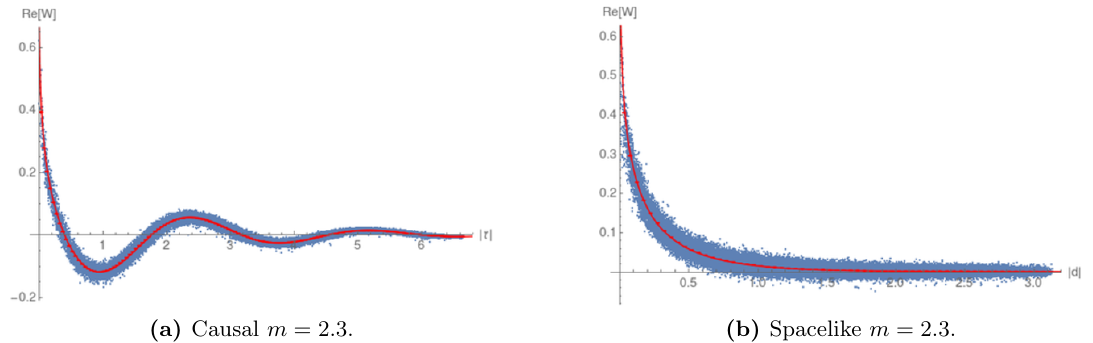
Figure 14. N = 36000 ; T = 1 : 5 ; (cid:26) = 203 : 15, in 2d de Sitter. Re[ W 100000 randomly selected pairs. The red curve represents the continuum W E from (5.4).